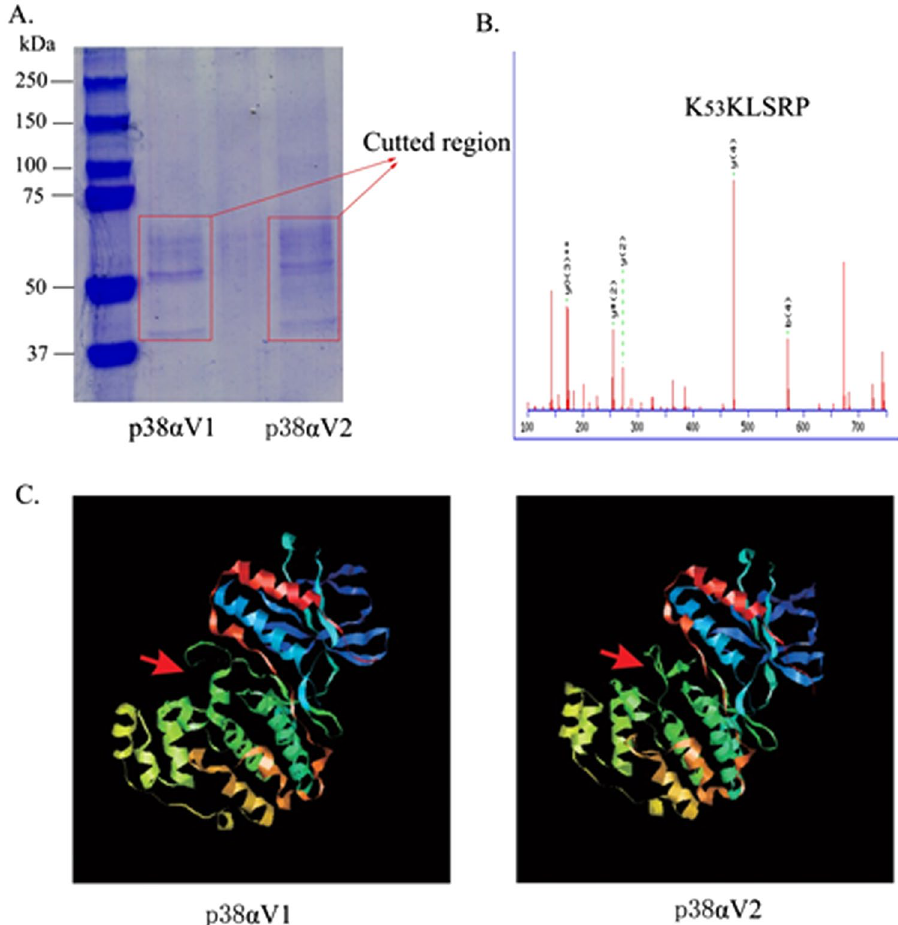
Figure 8. Analysis for polyubiquitination sites of p38 α and conformation of p38 α V1 and p38 α V2. ( A ) Coomassie blue stained gel indicates the bands of p38 α V1 and p38 α V2 with polyubiquitination. 293T cells co-transfected with p38 α V1-flag or p38 α V2-flag, HA-Nedd4, MKK6-HA and ubiquitin-His were lysed, immunopricipitated with Ni-column and anti-Flag purification beads, gel-separated, and stained with Coomassie blue. The square area indicates the presence of ubiquinated-p38 α V1 and p38 α V2. ( B ) K53(K54) residue of p38 α was identified as an common ubiquitination site in p38 α V1 and p38 α V2 by mass spectrometry. The protein sample with ubiquitinated p38 α V1 and p38 α V2 were recovered from the gel, enzyme digested, and subjected to mass analysis. Representative MS/MS spectra of peptides demonstrated ubiquitination at K53(K54) of p38 α V1 and p38 α V2. Peak matching expected y ions is labeled. ( C ) The conformational difference between p38 α V1 and p38 α V2. PDB documents (model No. 1p38 for p38 α V1; model No. 3py3 for p38 α V2) from SWISS-model, red arrows indicate the conformational difference between p38 α V1 and p38 α